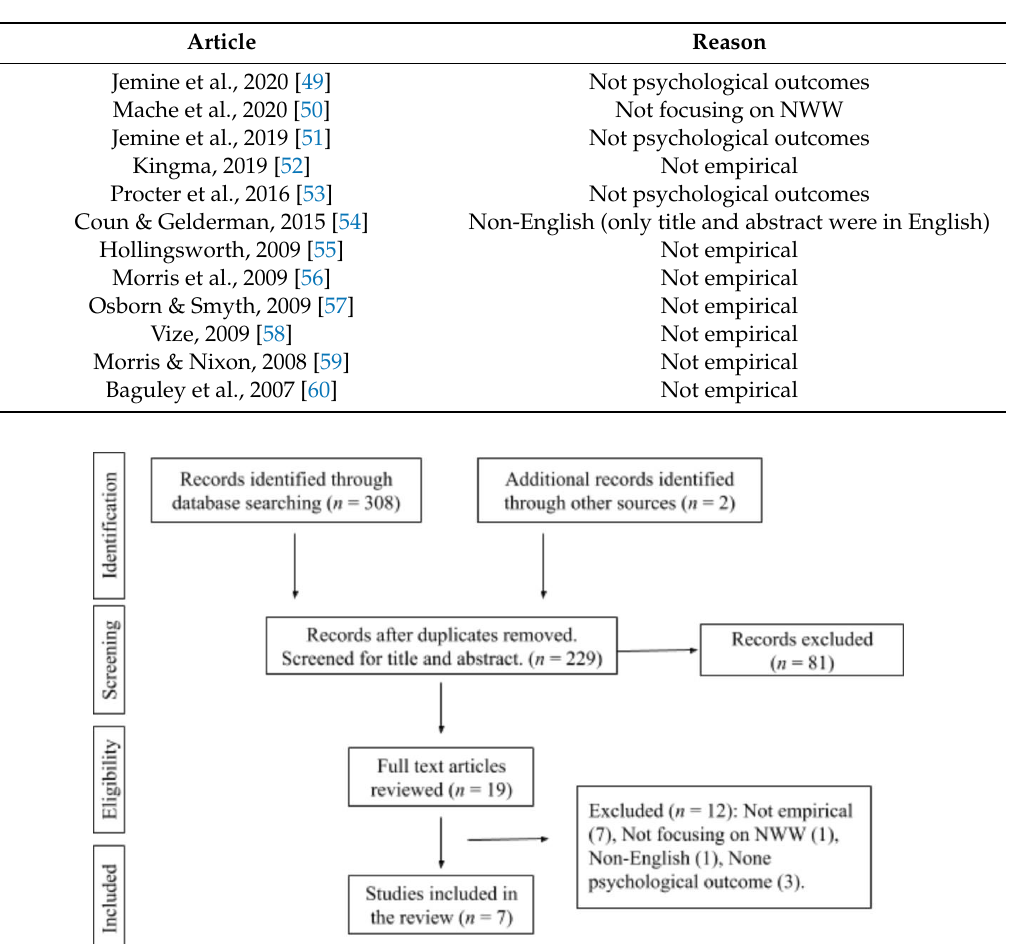
Table 3. Reasons for exclusion.